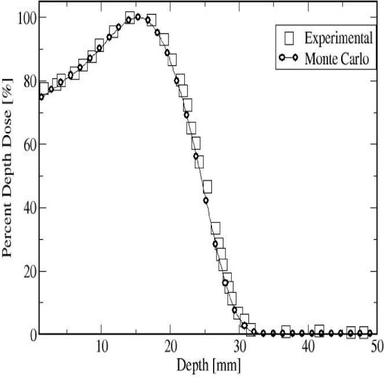
Experimental and calculated PDD for 6 MeV electrons on water.